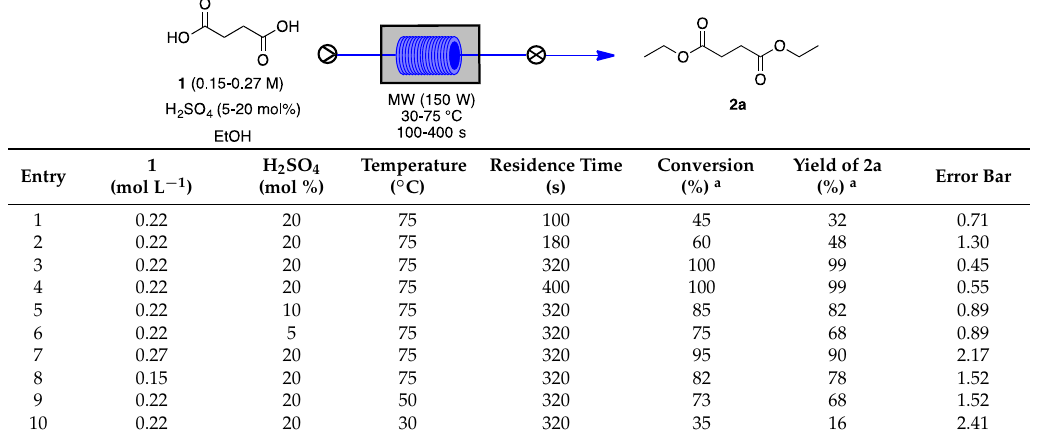
Table 3. Continuous flow microwave-assisted diethyl succinate ( 2a ) synthesis by varying the amount of SA ( 1 ), H 2 SO 4 , the residence time, and the temperature at 150 W.